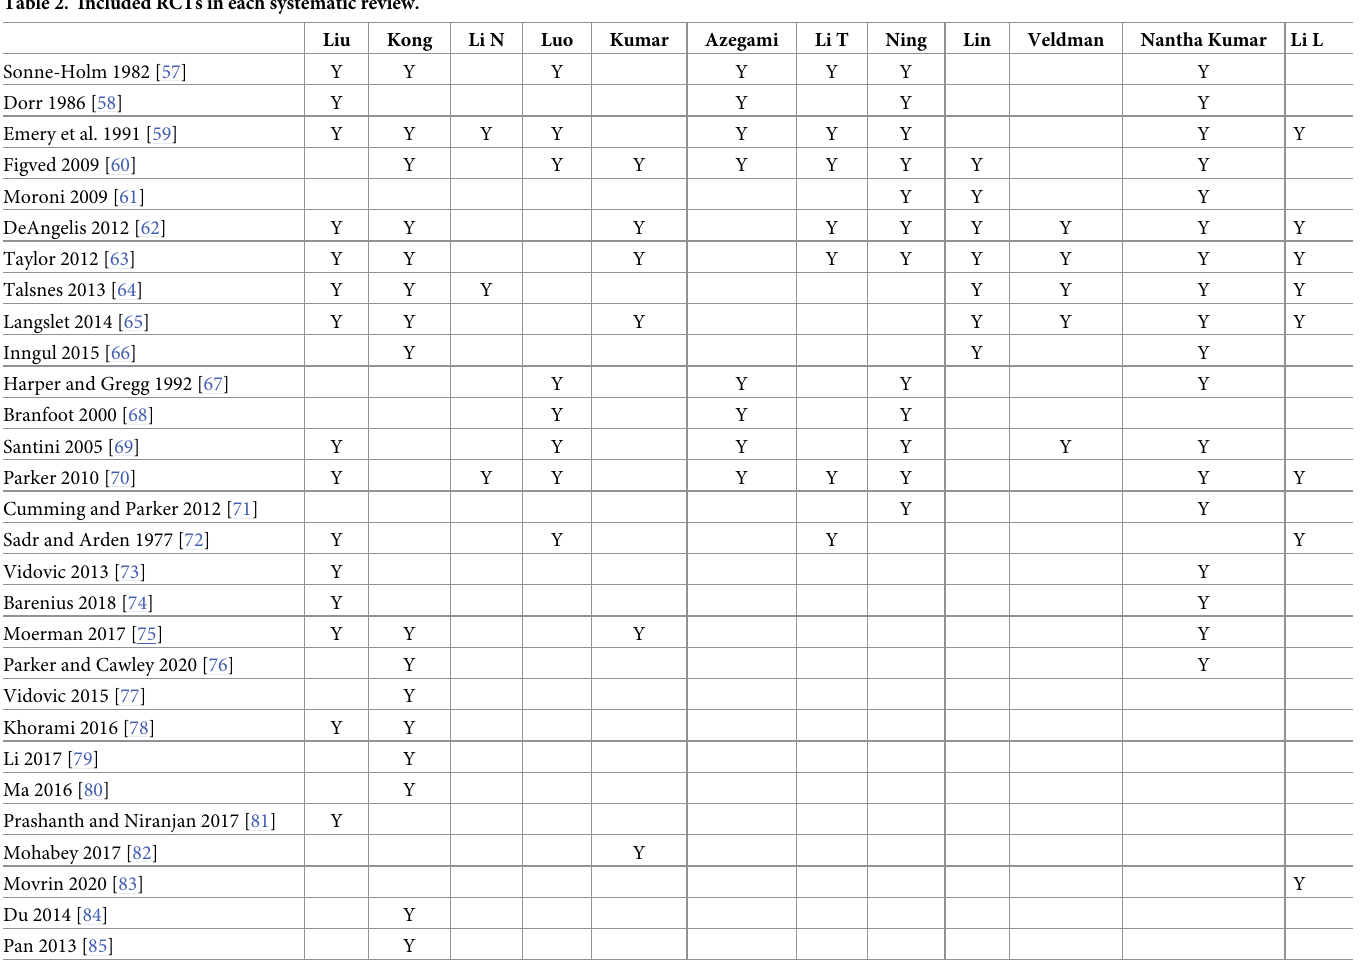
Table 2. Included RCTs in each systematic